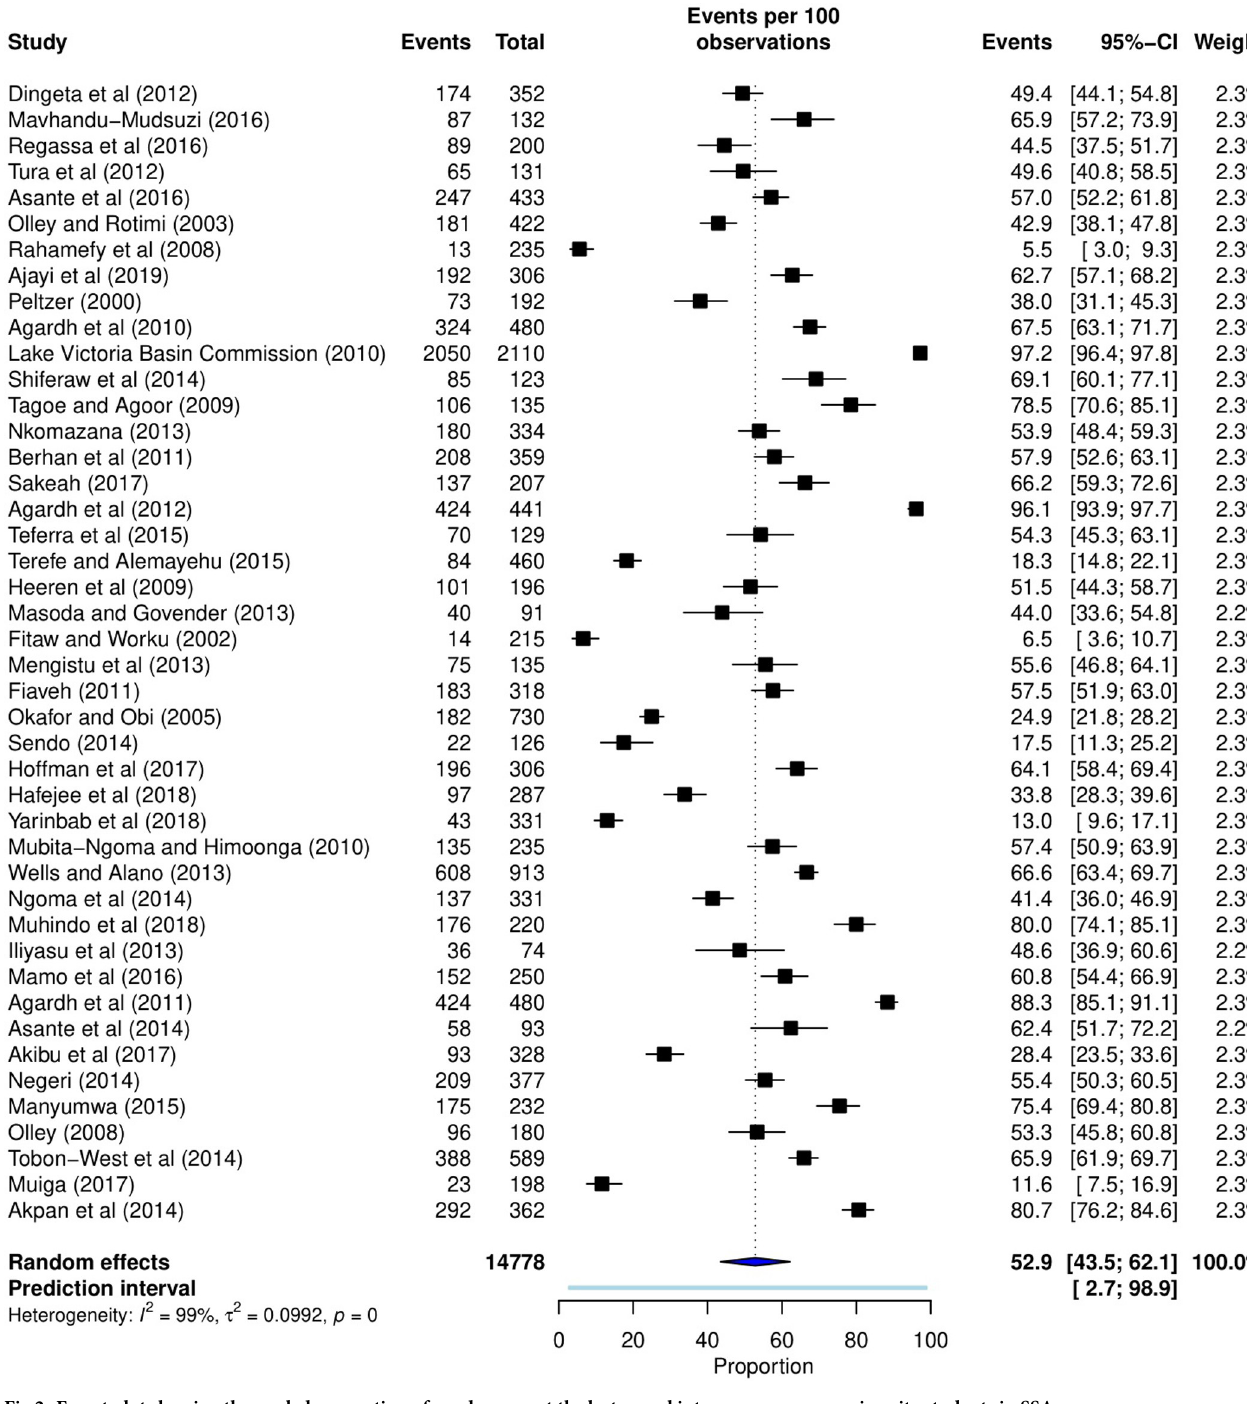
Fig 2. Forest plot showing the pooled proportion of condom use at the last sexual intercourse among university students in SSA.